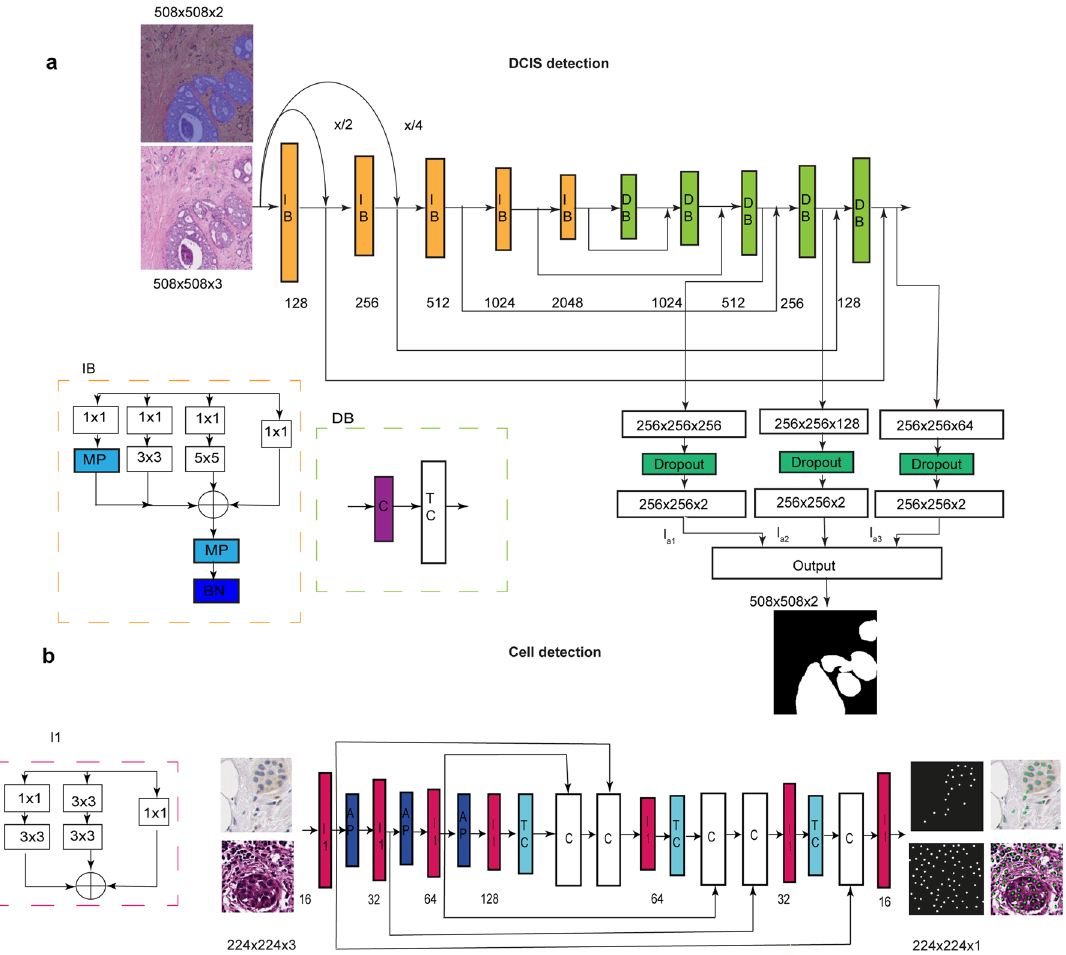
Fig. 2 Schematic of IM-Net architecture for detection and segmentation of DCIS and schematic of DRDIN cell detection network. a IM-Net architecture. Five inception blocks (IB) in the contracting path and fi ve decoder blocks (DB) in the expanding path used to encode features along with spatial context with multiple inputs applied to the respective fi rst three blocks. Inception blocks with batch normalisation performed on resized images generate feature maps from the convolution blocks (IB 1 , IB 2 and IB 3 ). Resized image by a factor of 2 and 4 are represented as x /2 and x /4, respectively. Features from the convolution blocks were preserved and passed to the expanding path comprising decoder block with concatenate (C) and transpose convolution block (TC) as the basic units that aid to preserve crucial low-level information for DCIS boundary localisation. b DRDIN architecture has a dense cross-connection from the inception blocks (I1) in the encoder and the decoder path. Components of I1 comprises 3 × 3 and 1 × 1 kernel convolutional fi lters. In the encoder path, average pooling (AP) is used and the decoder path consisted of transpose convolution (TC), concatenate (C) layers.